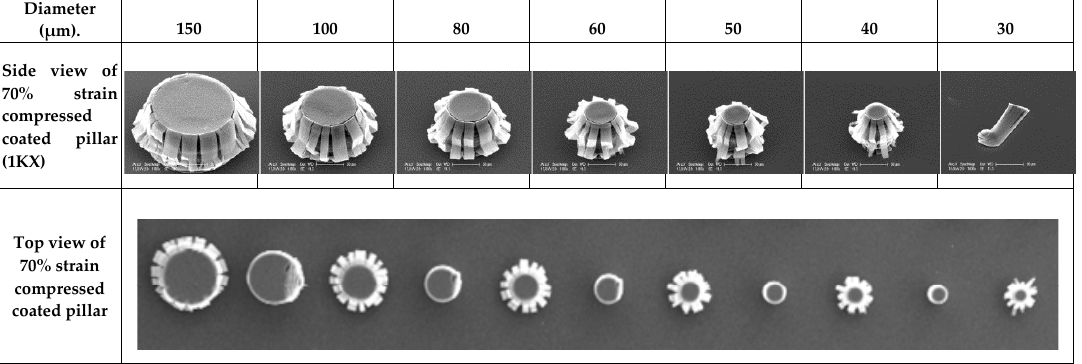
Figure 7. SEM images of 20 nm NbTiN coated CNT pillars after 70% compressed strain of various diameters.